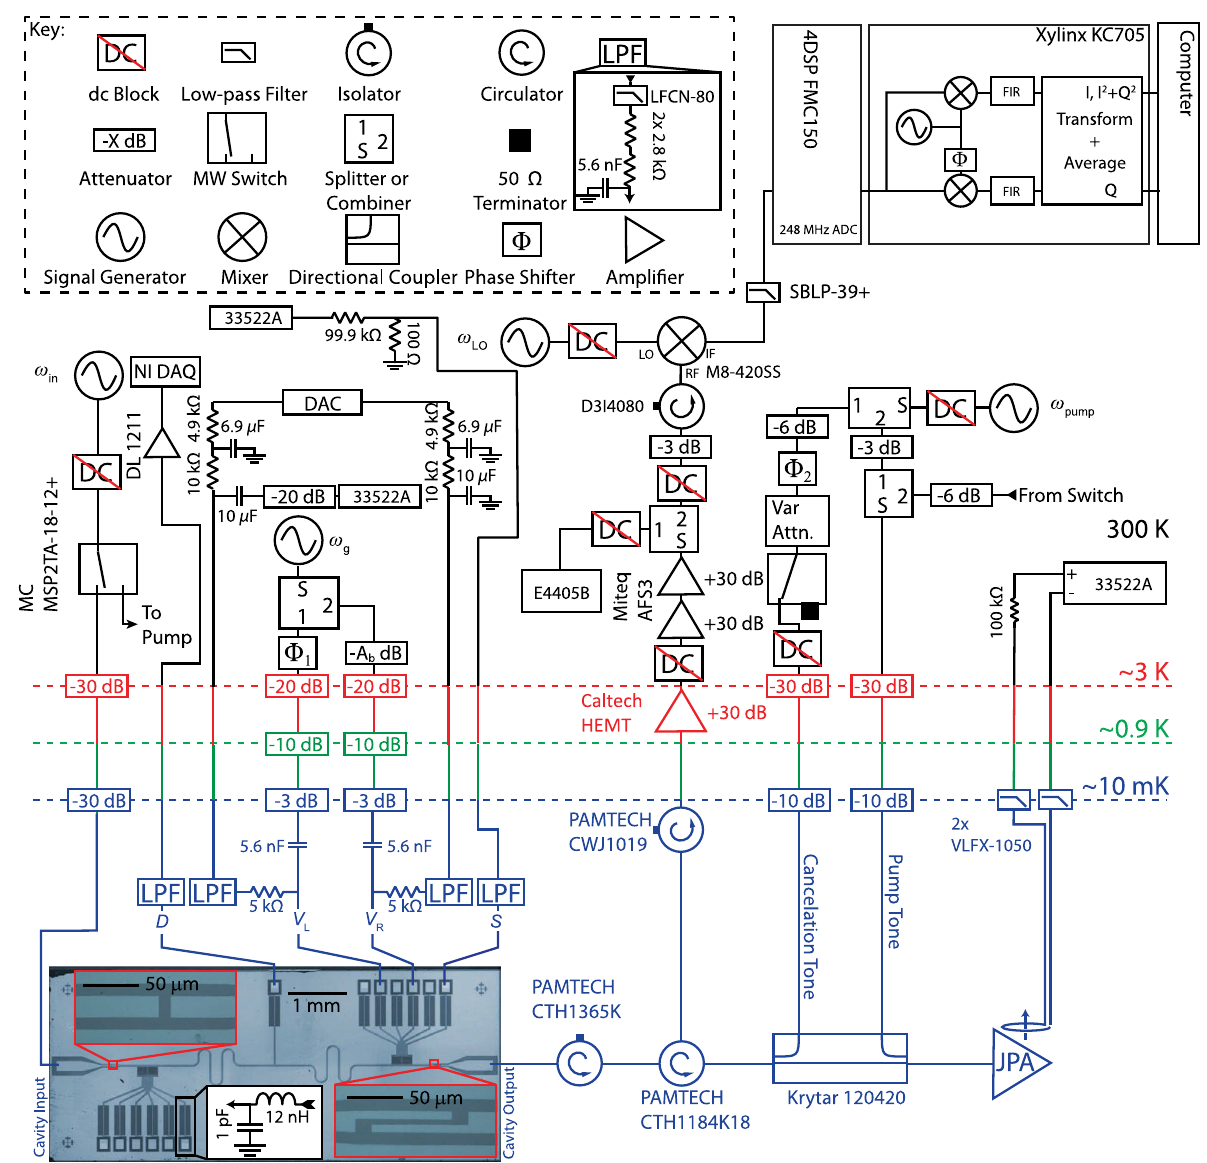
FIG. 4. Complete circuit diagram of the experimental setup. We probe the cavity transmission using a tone at frequency ω . The cavity in output field is amplified using a JPA. The JPA is biased using a small magnetic coil fed from an Agilent 33522A function generator. The pump field at frequency ω is supplied using a directional coupler. At room temperature the pump field is also split and phase shifted pump to provide the cancellation field, which is optionally used to remove the pump field that is reflected off the JPA. The resulting signal is further amplified, before being sent either to an Agilent E4405B spectrum analyzer or downconverted to 20.48 MHz and digitized using a 4DSP FMC150 board. A final digital downconversion and digital filtering stage then recovers the signal. To generate the Floquet gain medium time varying gate voltages are applied. The dc part is generated using a digital to analog converter (DAC) that is heavily filtered both at room temperature and in the 10 mK stage. The ac excitation at frequency ω is provided using a signal generator and added to the g dc part via a bias-tee circuit. The current is measured using a DL 1211 preamplifier and digitized using a NI